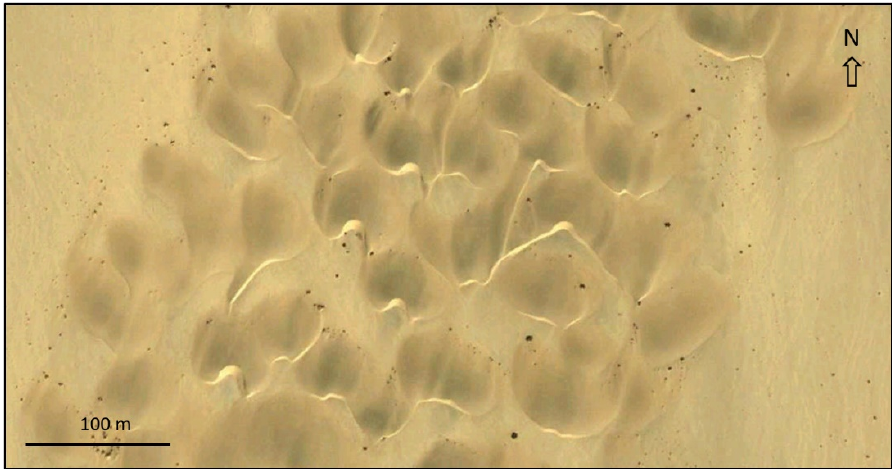
Figure 10. Barchans of El-Hebal Dunes. Source: Google Earth image © 2019 CNES/Airbus.